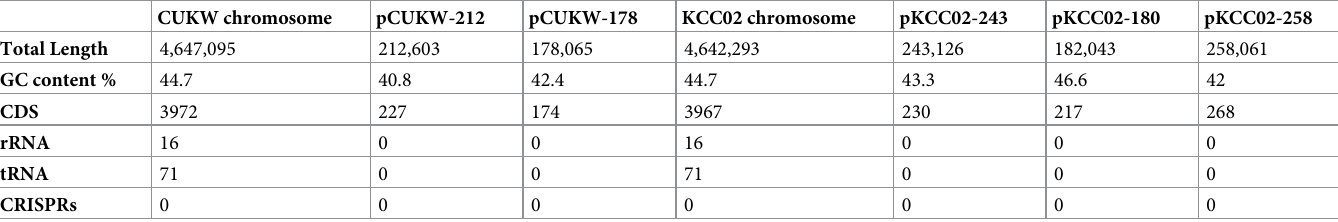
Table 6. Genome statistics of strains CUKW and